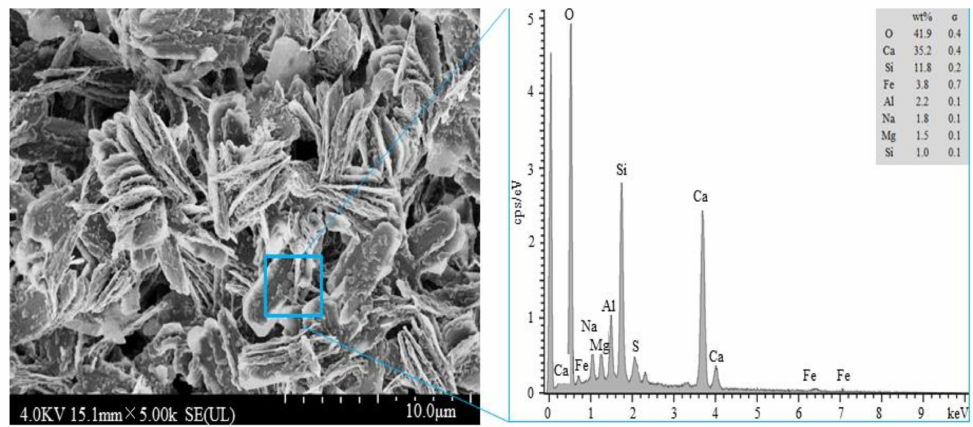
Figure 10. Scanning electron microscope energy dispersive spectroscopy (SEM–EDS) of the control sample at 60 d.